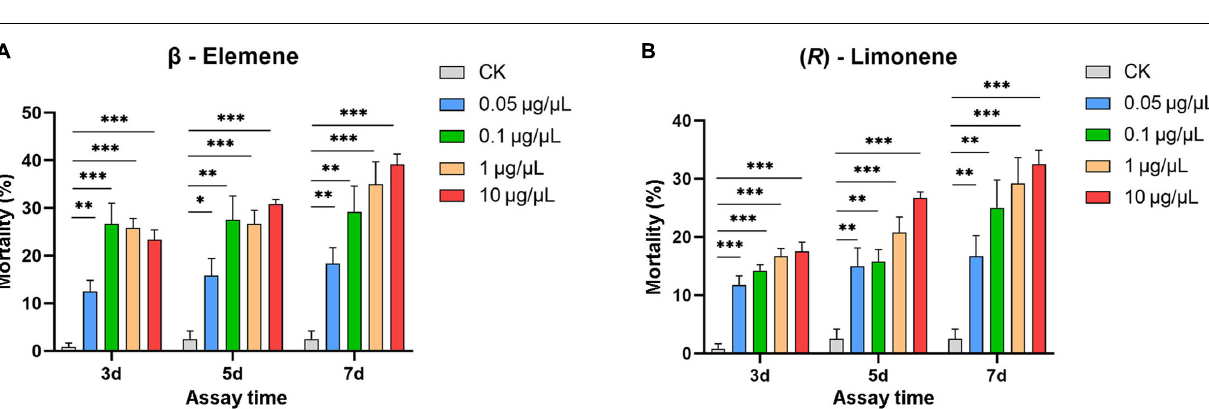
FIGURE 7 | Behavioral preference of Helicoverpa armigera larvae to β -elemene (A) and limonene (B) . Data were tested for significant differences using χ 2 analysis (** P < 0.01; *** P < 0.001).